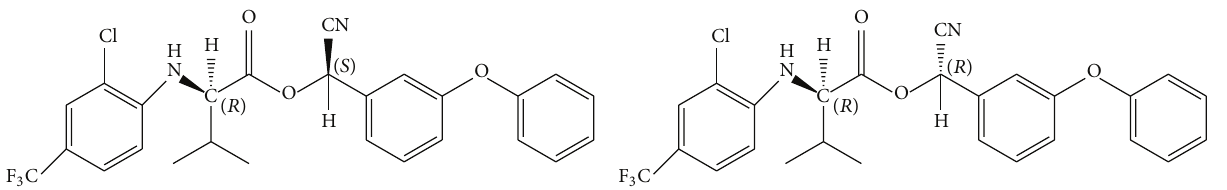
Figure 1: Chemical structures of TFLV